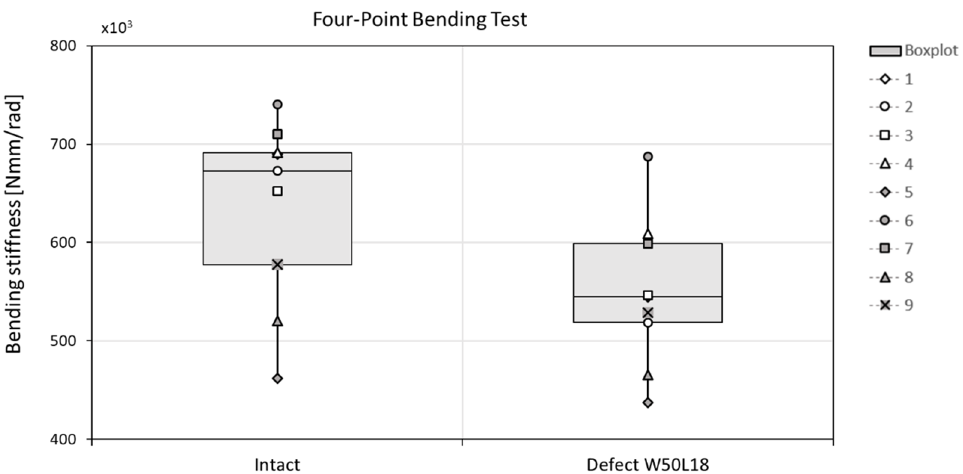
Figure 4. The bending stiffness decreases when a cortical window is created in the center of a sheep radius diaphysis, determined with a four-point bending test. The differences were not significant.